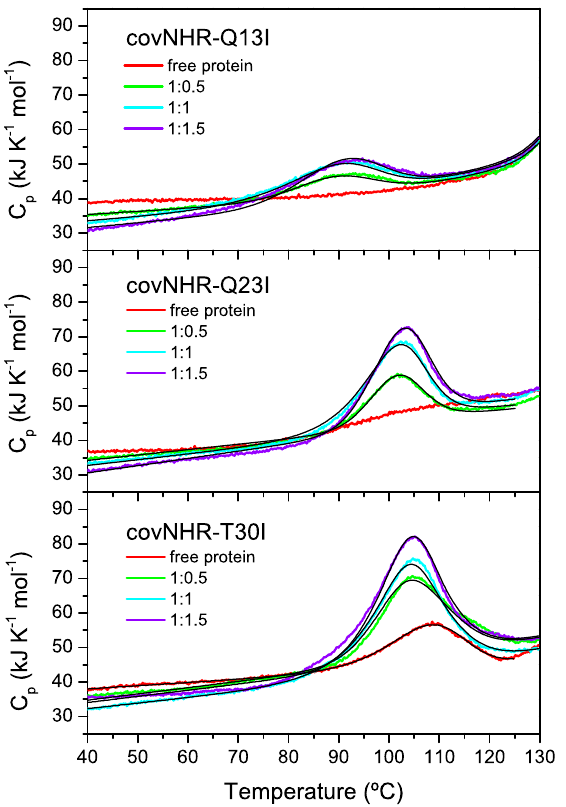
Figure 4. DSC analysis of thermally induced dissociation of the complexes of covNHR mutants with W34L. Protein–peptide mixtures were analyzed at the indicated molar ratios. The experimental data are represented in colors. The black solid lines represent the best fittings using the model of ligand binding coupled to a Lumry–Eyring denaturation.